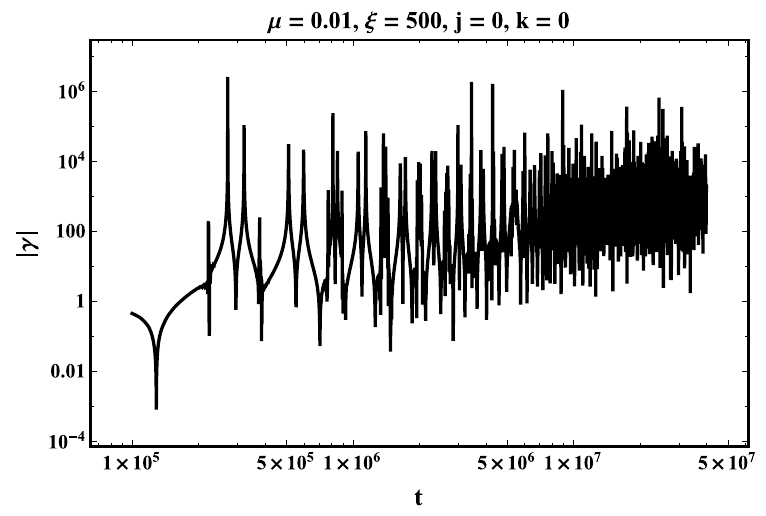
Figure 10 . The time evolution of the adiabaticity